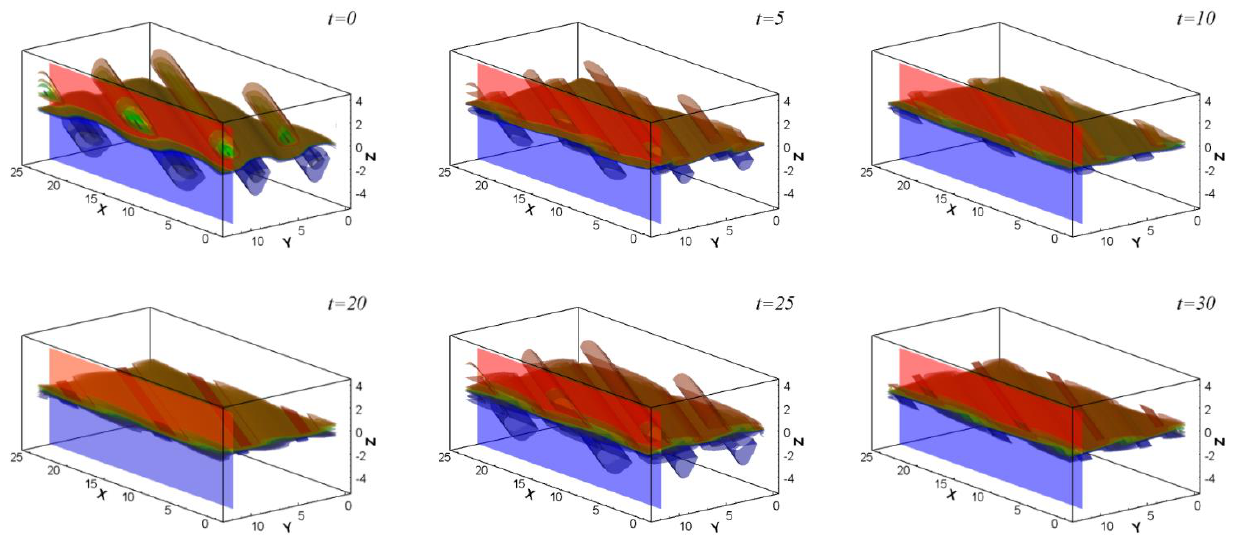
Figure 8. Time evolution of the 3D optimal temperature perturbation superposed with base flow profile for Ri = 2, Re = 1000, α = 0.5, β = 1, yielding the maximal values at t max = 10. The blue color corresponds to cold fluid; the red color corresponds to warm fluid. The growth function increases at t = 0, 5, 20, 35, attains maximal values at t = 10, 25, and decays at t = 15,